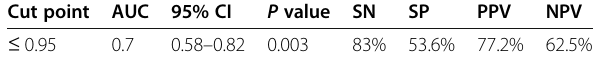
Table 6 Diagnostic accuracy of ADC cut point in discriminating grade III lesions Cut point AUC 95%